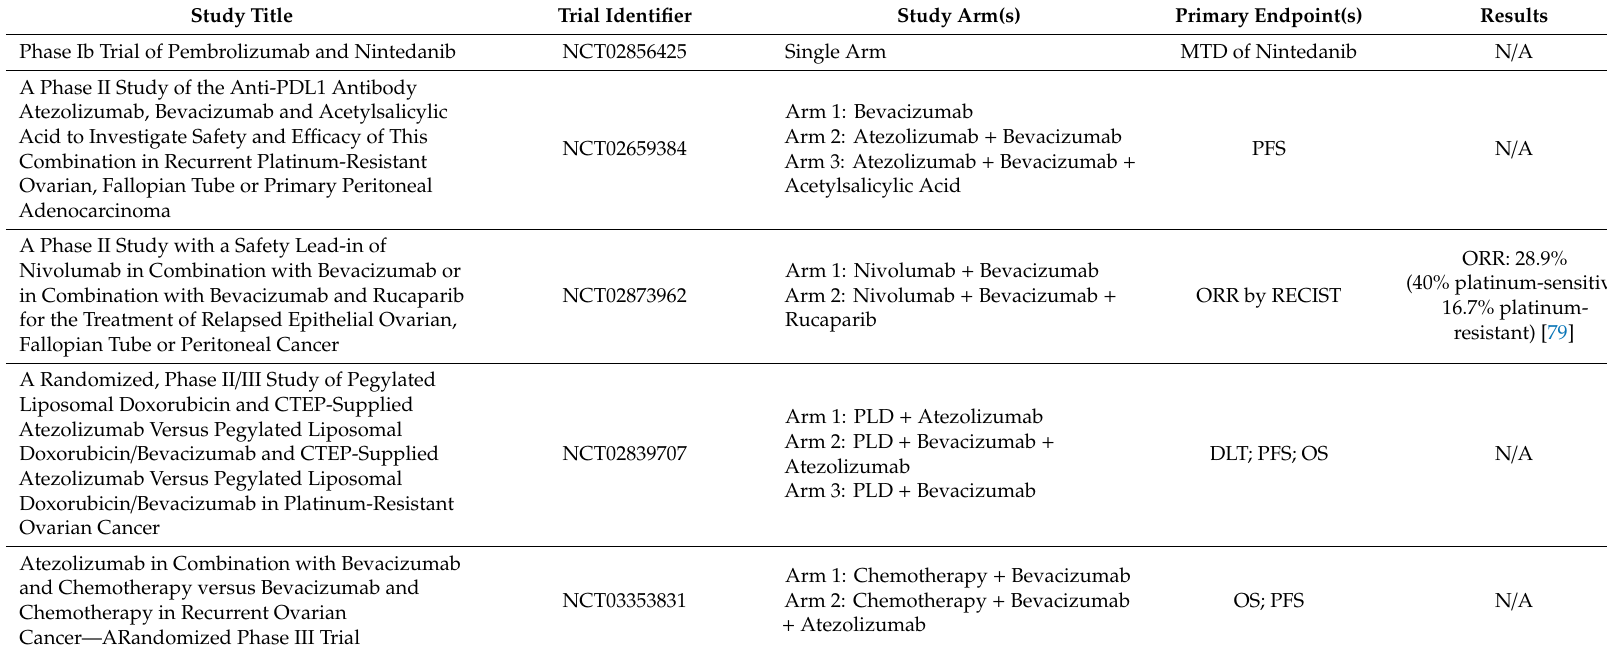
Table 2. PD-1 and anti-angiogenic